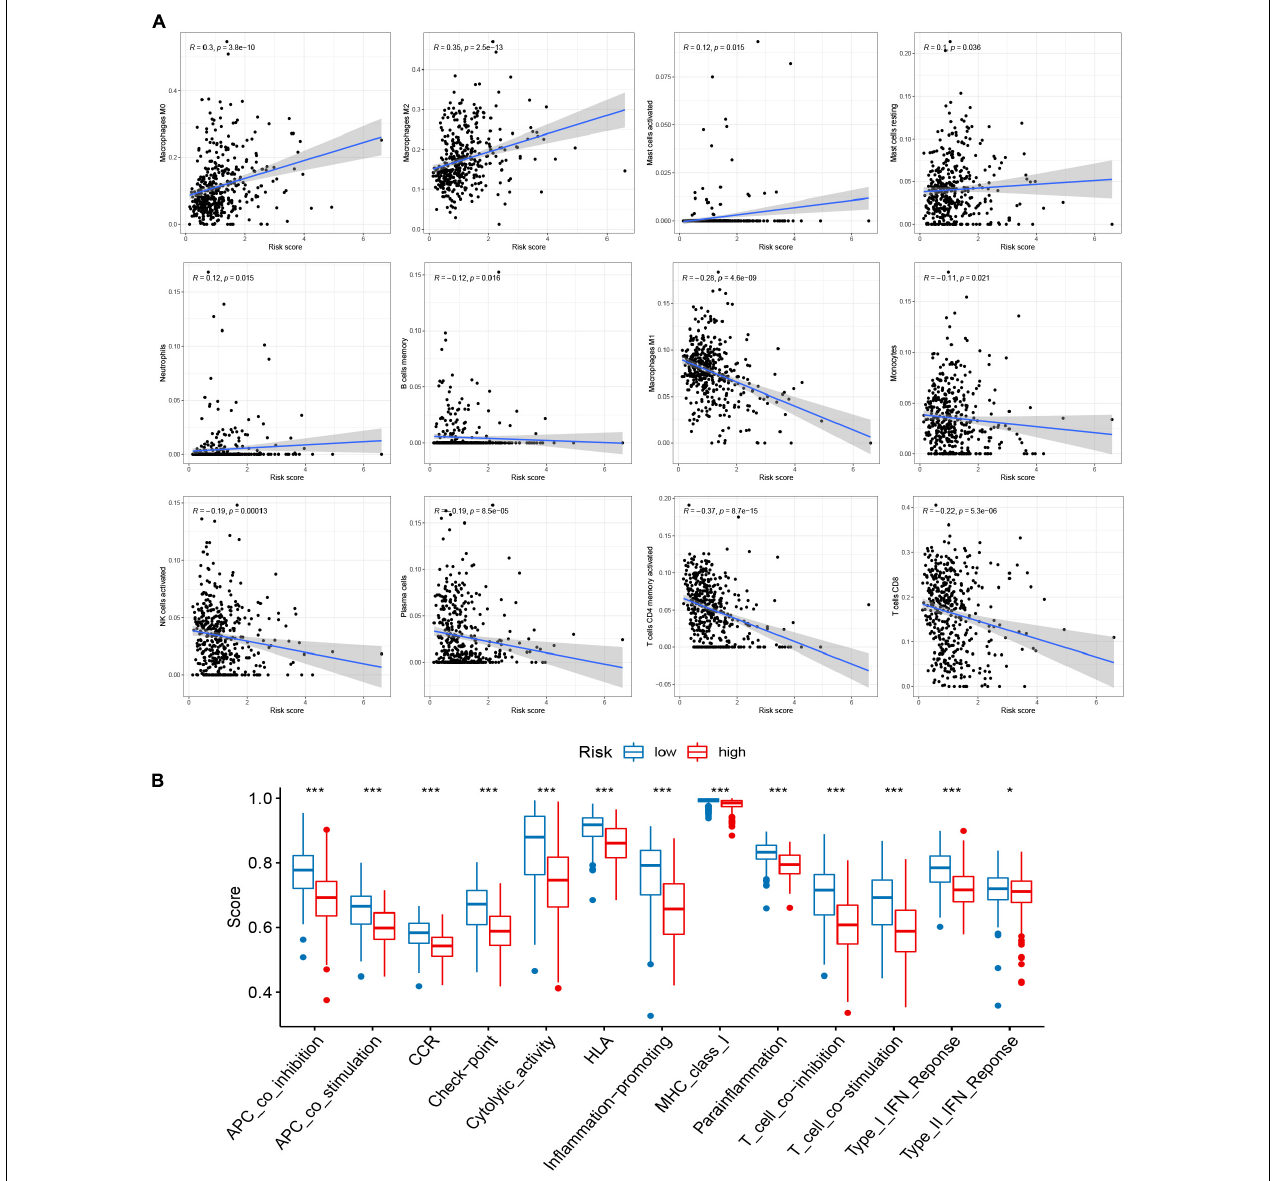
FIGURE 4 | Relationships between the signature and tumor immune cell microenvironment. (A) Infiltration abundances of immune cell types. (B) 13 immune-related functions. * p < 0.05 and *** p < 0.001.